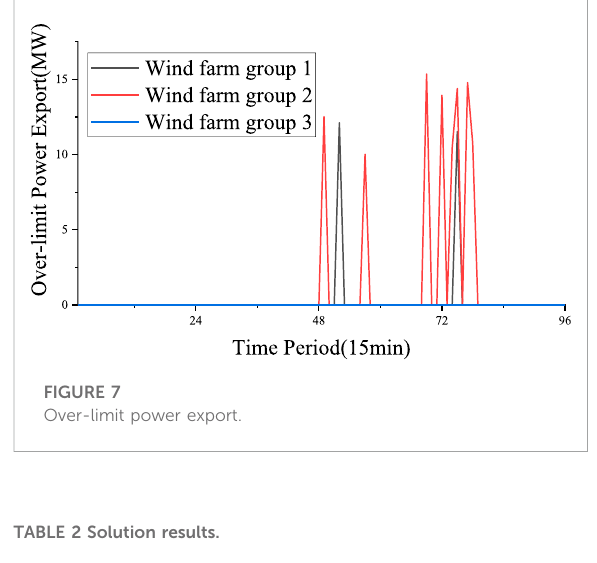
TABLE 2 Solution results.